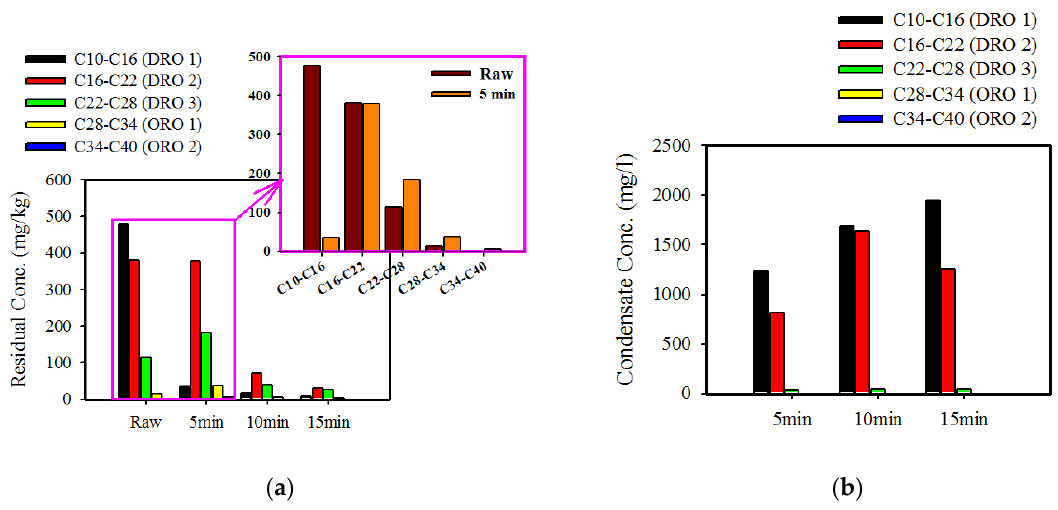
Figure 5. Concentration of di ff erent fraction on ( a ) soil and ( b ) condensate in TPH as a function of treatment